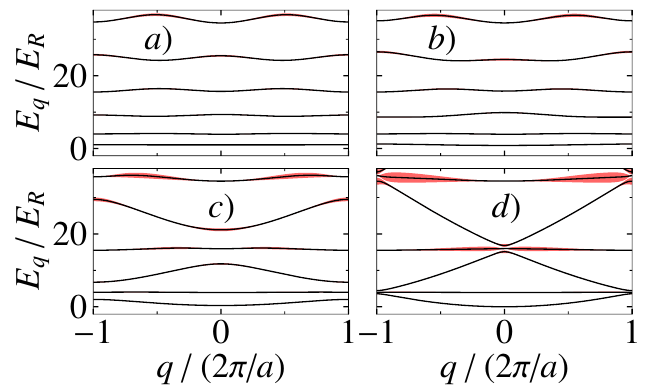
Figure 8: The first six Bloch bands ( s = 1,2,...6), obtained by diagonalizing the full Hamiltonian (7) in the expanded 1BZ for a) α = 0, b) α = 30 ◦ , c) α = 60 ◦ and d) α = 85 ◦ with ε = Ω plots the spectral line widths are magnified by a factor of